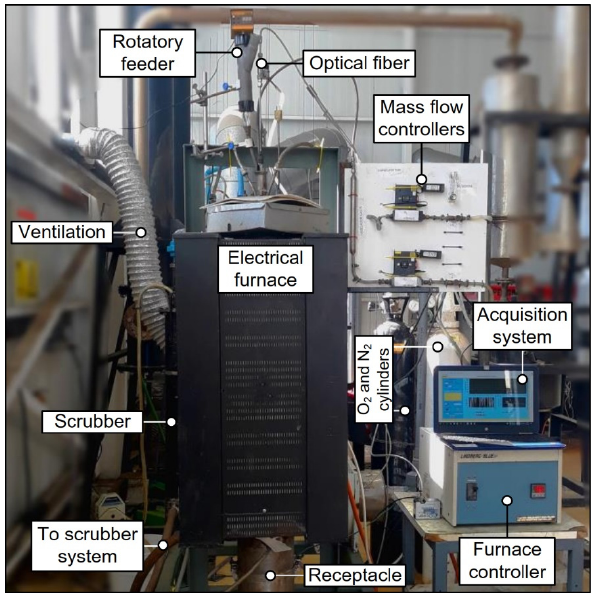
Figure 4. Experimental set-up [23].